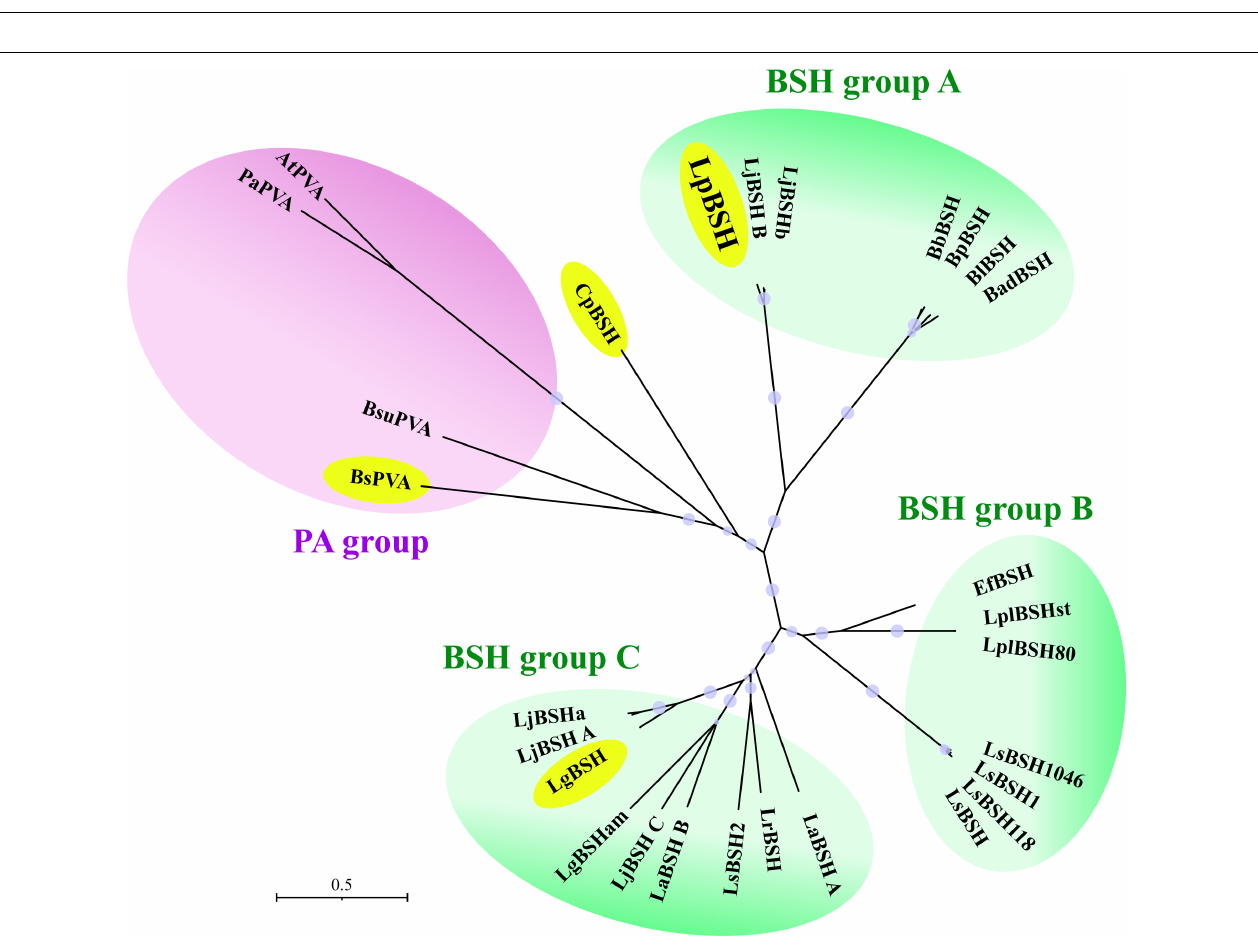
FIGURE 6 | Phylogenetic analysis of LpBSH with cysteine-nucleophile Ntn-hydrolase proteins. Amino acid sequences of experimentally identified Ntn-hydrolase proteins were used in this analysis. Each enzyme name was simply defined based on the names of the host’s genus and species (e.g., LpBSH: Lactobacillus paragasseri derived BSH; for more information, please see Supplementary Table 1 ). The phylogenetic tree was constructed by the neighbor-joining method with MEGA X software (1,000 bootstrap replications). The evolutionary distances were computed using the Poisson correction method and are expressed as the units of the number of amino acid substitutions per site. The phylogenetic tree was divided into four groups [one PA group (purple background) and three BSH groups (green background)]. Four bifunctional acylases with PA and BSH activities (LpBSH, BuPVA, CpBSH, and LgBSH) were enclosed by yellow circles. Bootstrap values greater than 50% based on 1,000 replications are shown by circle symbols whose size correlates with the bootstrap values.